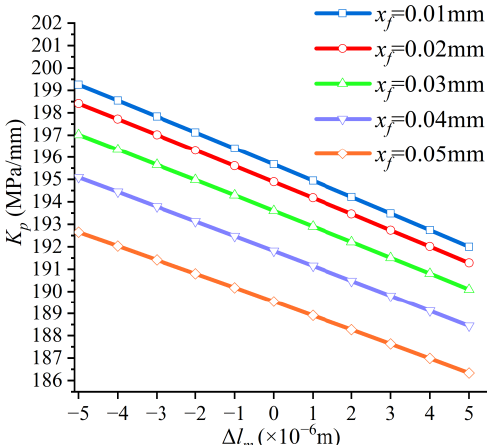
Figure 25. Drift of average pressure gain caused by shunt wedge width variation.